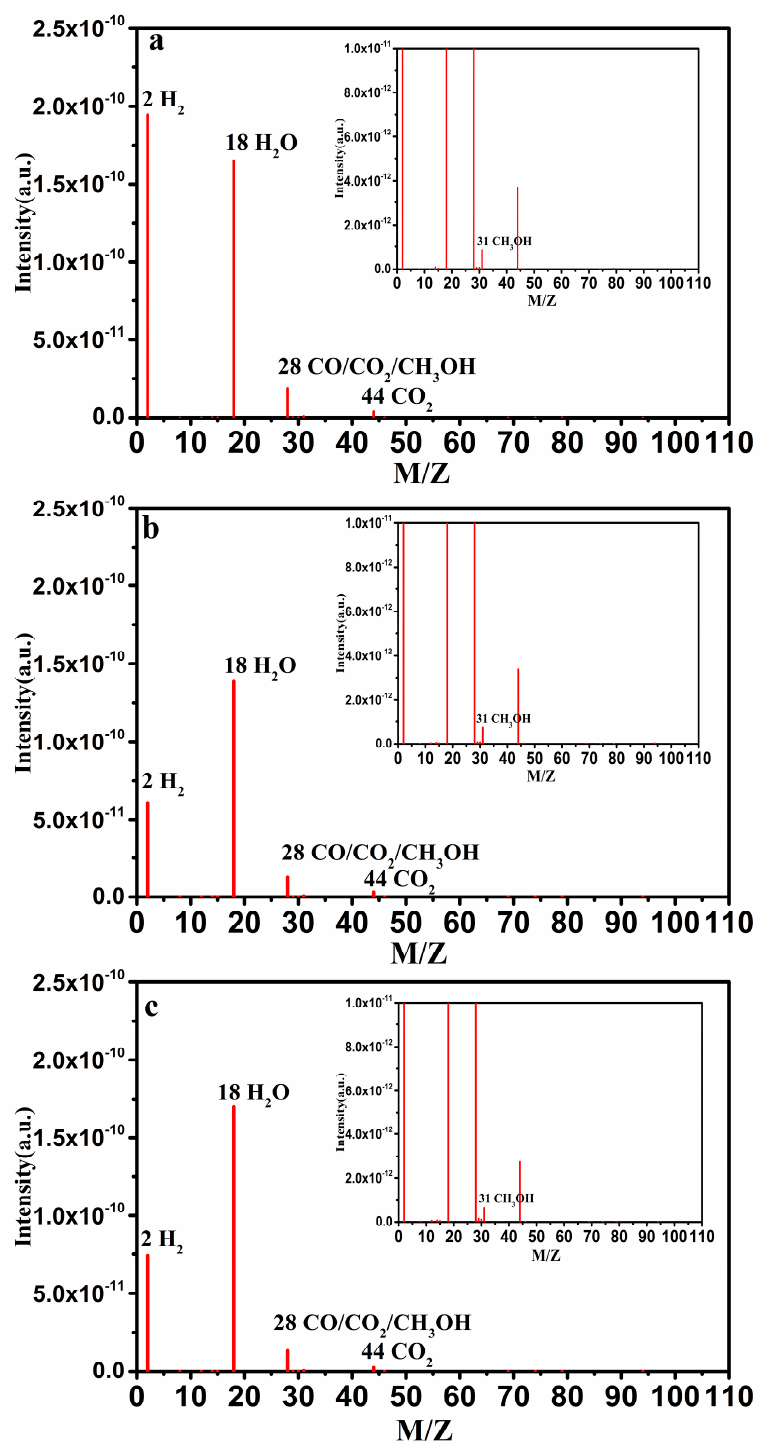
Figure 9. Mass spectrometry of the tail gas produced during the thermocatalytic decomposition of DMMP on ( a ) 2MCeO 2 np, ( b ) 12MCeO 2 nr, and ( c ) 12MCeO 2 nc. (The insets show the high magnification picture of 25 times).